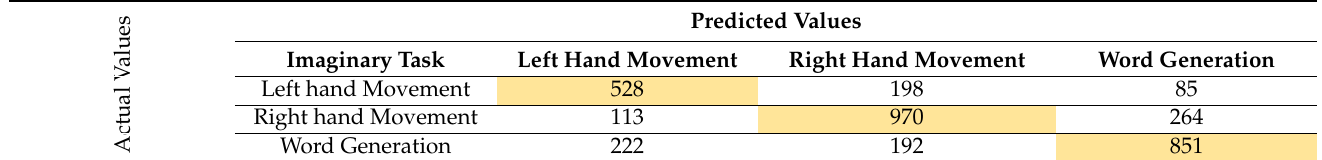
Table 5. Confusion matrix of subject 2.